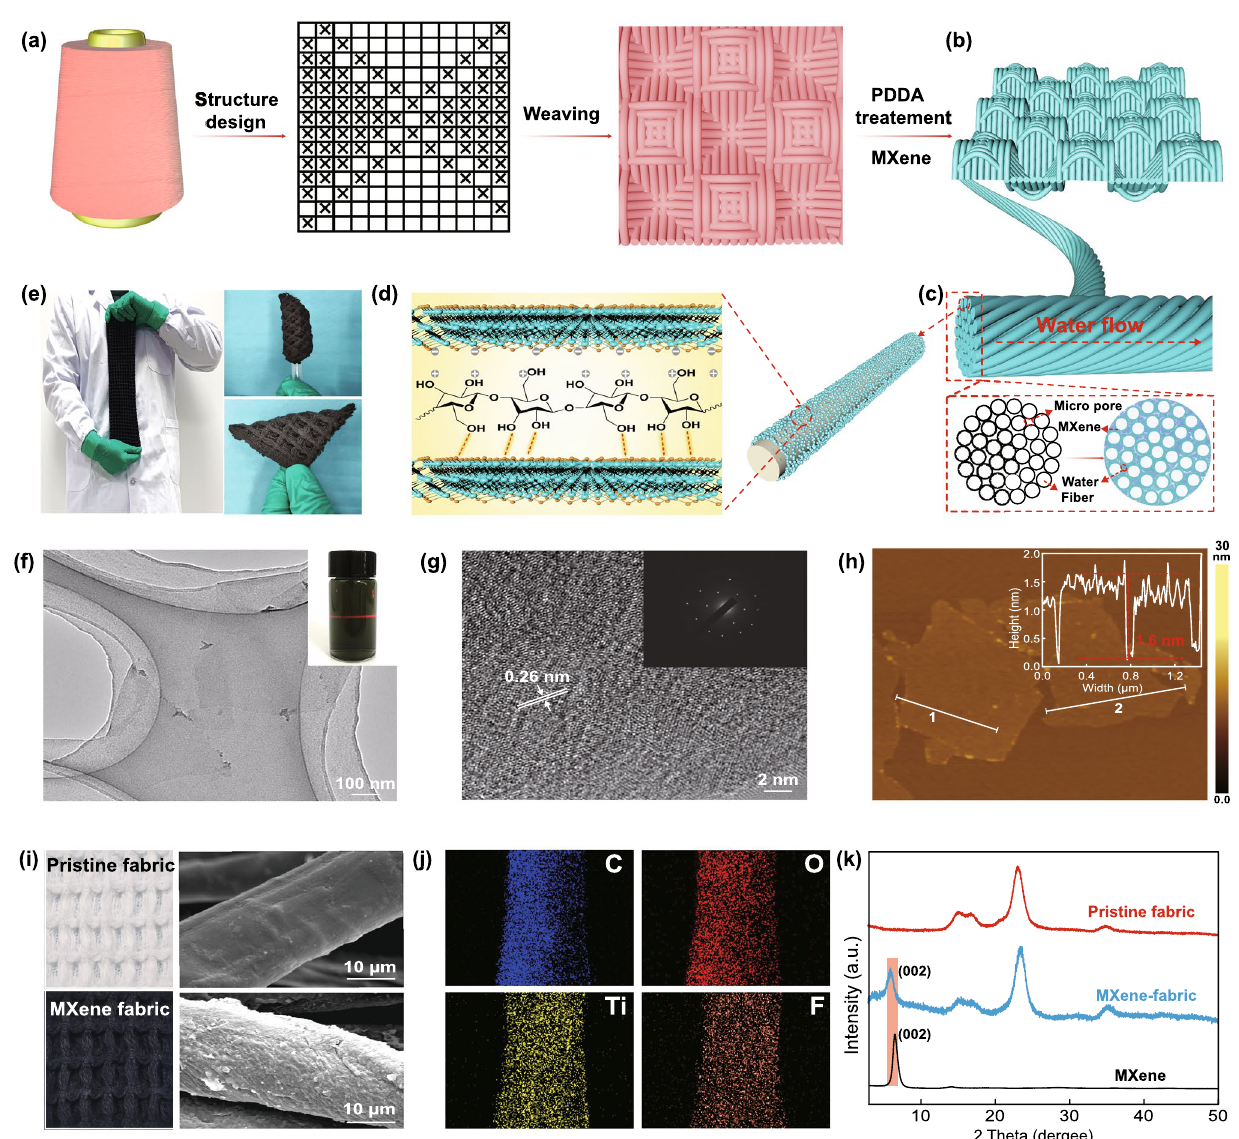
Fig. 2 a Schematic diagram of the fabrication process of the 3D honeycomb fabric. b – c Schematic diagram of the 3D honeycomb fabric and yarn after PDDA/MXene coating. d Schematic diagram of the interactions between MXene and the fibers. e Digital images of the flexible MXene/3D honeycomb fabric (length, 30 cm; width, 10 cm). f TEM image and the Tyndall effect of MXene. g HRTEM image of MXene. h AFM image of MXene. i SEM images of pristine and MXene/3D honeycomb fabrics. j EDS elemental mapping of C, O, Ti, and F in the MXene/3D honeycomb fabric. k XRD mapping of MXene, the MXene/3D honeycomb and pristine 3D honeycomb